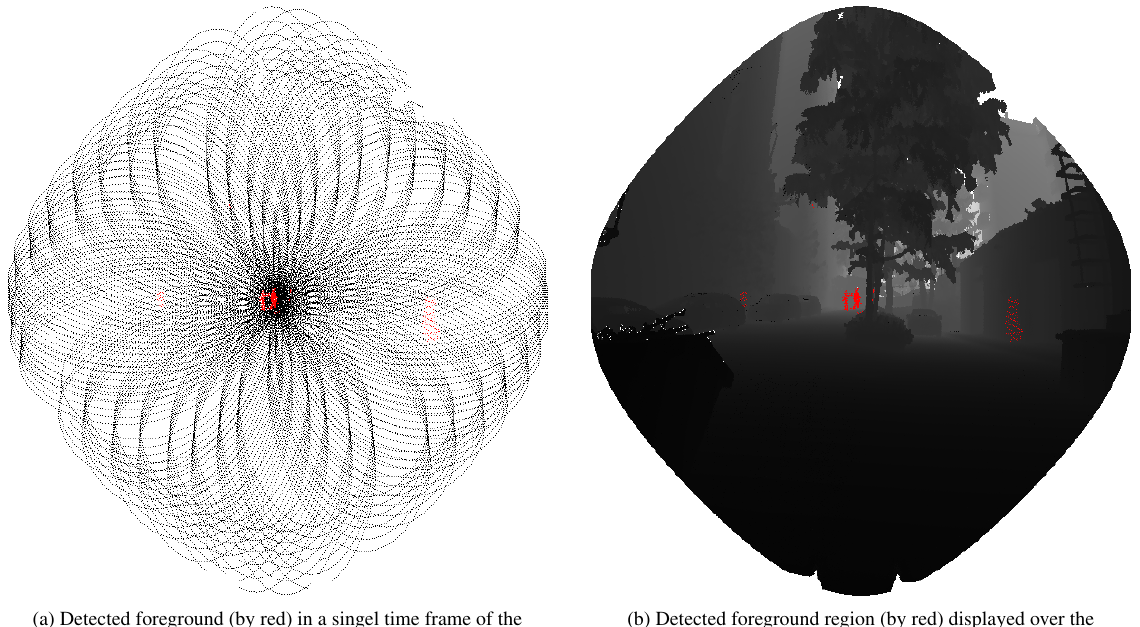
Figure 4. Foreground detection results (by red) in the City Center scene, displayed in 3D point cloud representation.